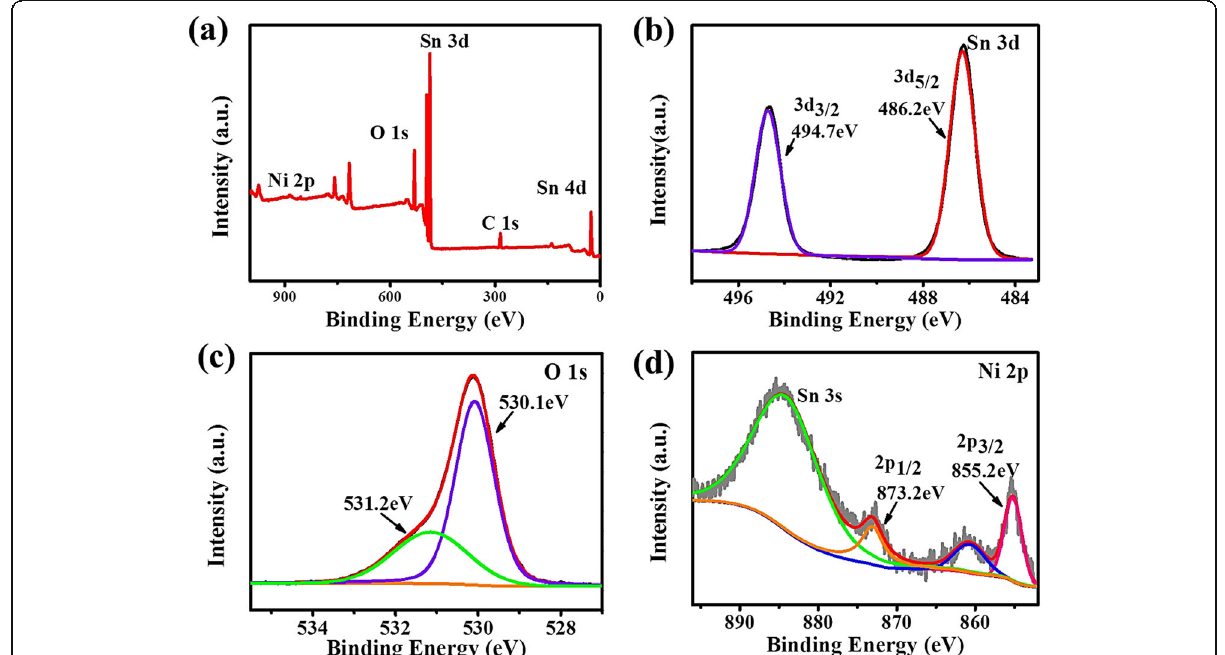
Fig. 5 XPS spectra of a full spectrum, b Sn 3d, c O 1s, and d Ni 2p core-level spectra of annealed SnO 2 :NiO